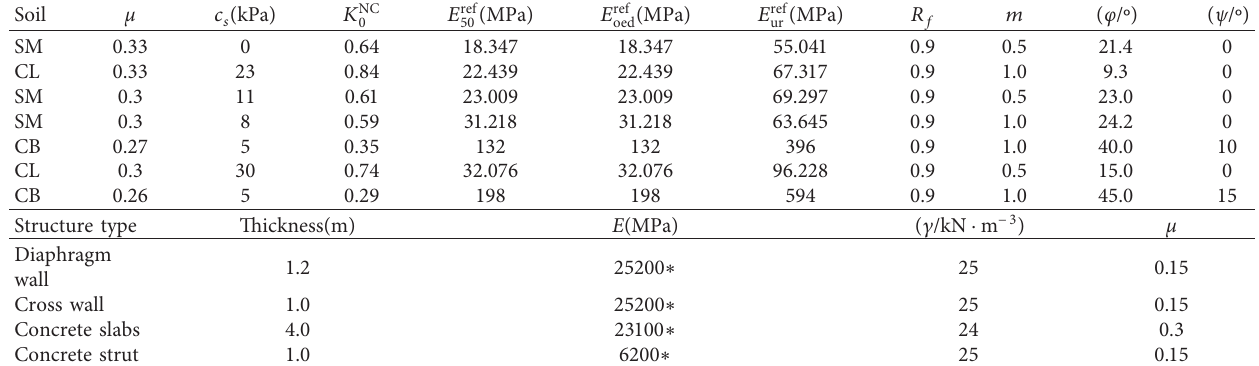
Table 2: Input parameters of the soil layer and structural members for the YDM